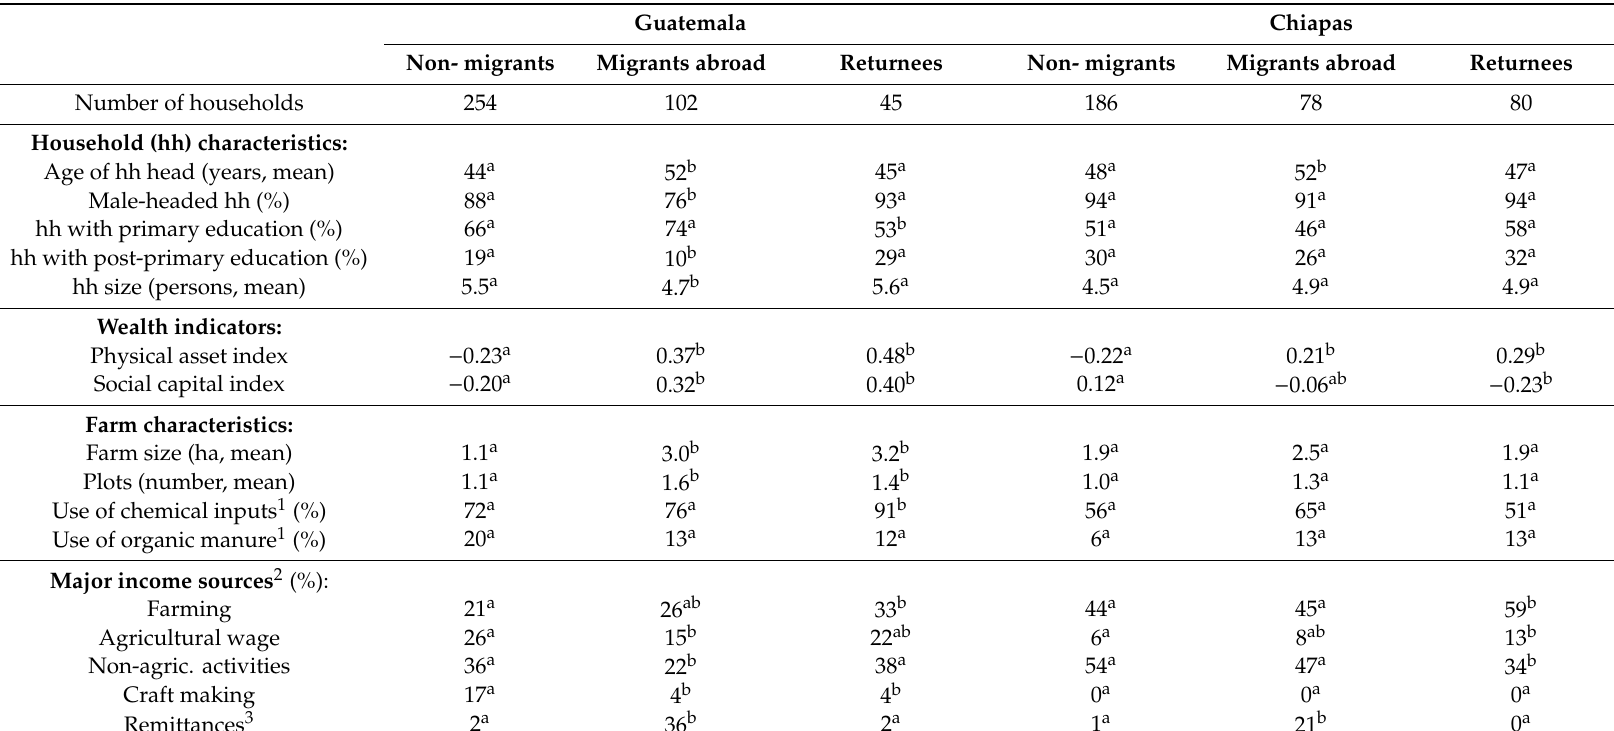
Table 3. Characteristics of migrant and non-migrant households. Guatemala